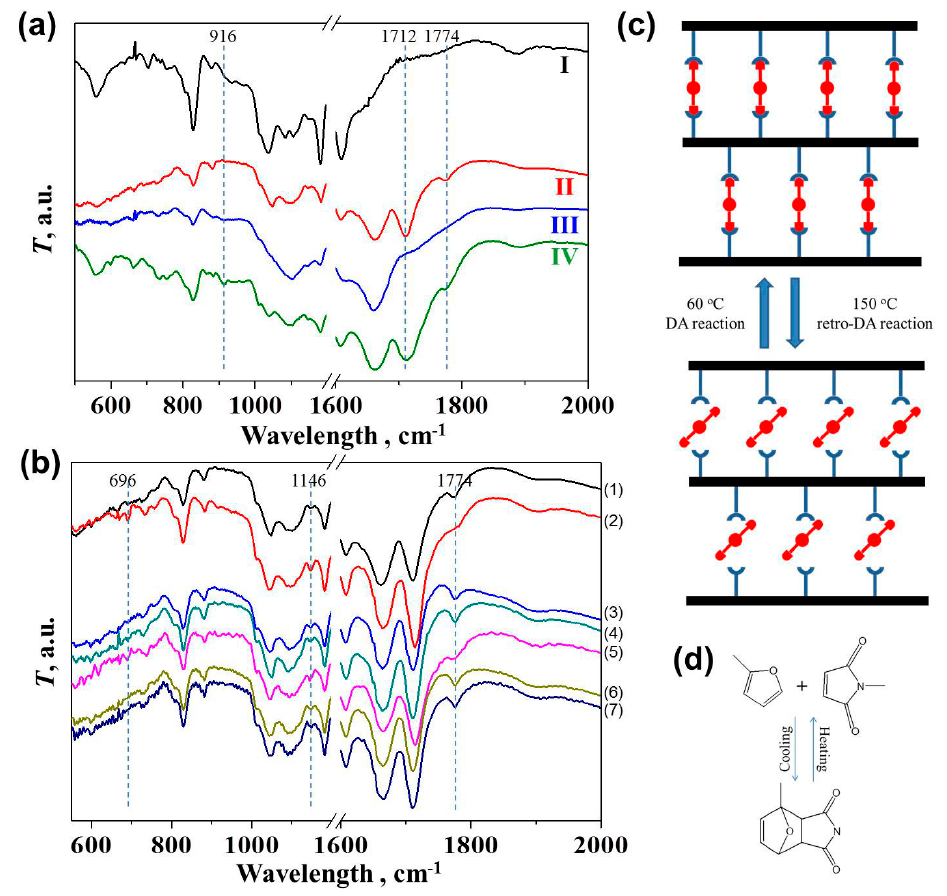
Figure 2. ( a ) FTIR spectra of Networks I, II, III, and IV; ( b ) The FTIR spectra evolution of Network II after different thermal treatments: (1) as prepared, (2) 150 ◦ C for 10 min, (3) 60 ◦ C for 1 h, (4) 60 ◦ C for another hour, (5) 150 ◦ C for 10 min, (6) 60 ◦ C for 1 h, (7) 60 ◦ C for another hour; ( c , d ) Schematic diagrams showing the reversibility of Network II and the DA reaction.